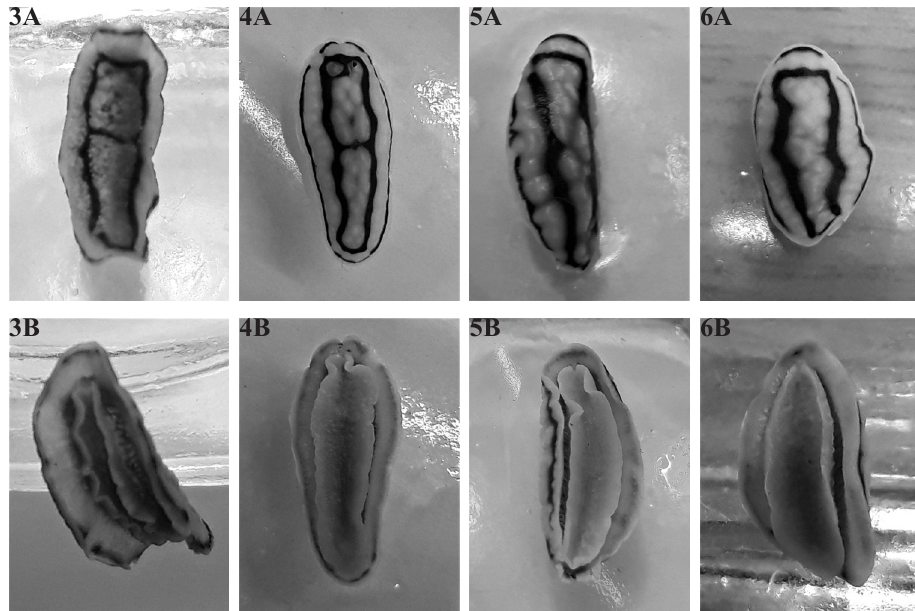
thin black line submarginally and faint black markings within the central black ring. The individual tubercles in the central black ‘square’ and the multiple tubercles in the wide marginal pink band are as described previously: the pink areas are tuberculate with some or triple row of tubercles, which appears to be another diagnostic character of P. zeylanica